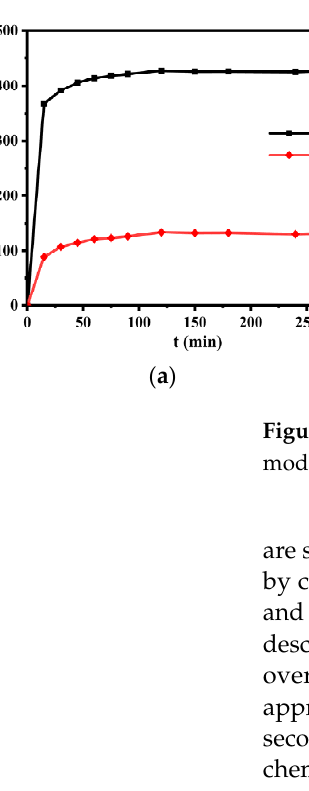
Table 8. The parameters of the pseudo-first-order and pseudo-second-order